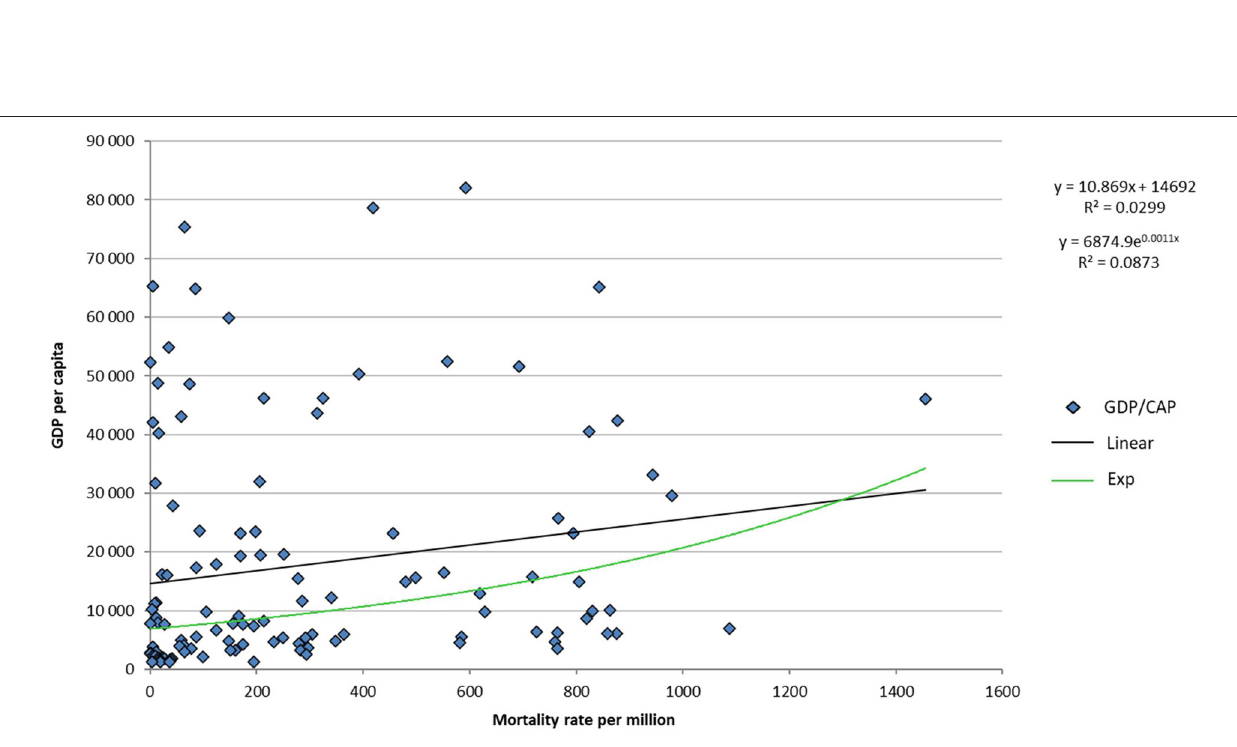
Frontiers in Public Health | www.frontiersin.org